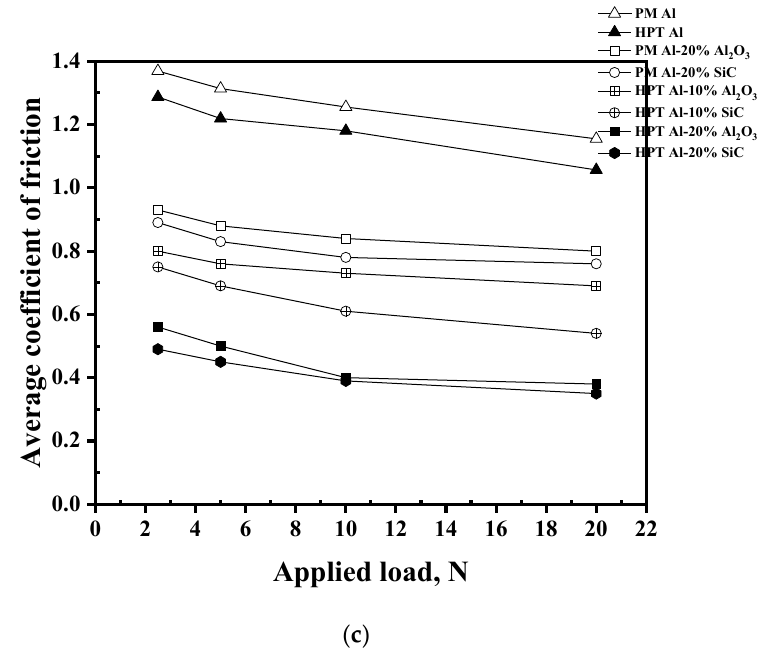
Figure 6. Average COF of the different samples under different applied loads and sliding distances of ( a ) 315, ( b ) 630, and ( c ) 1260 m.